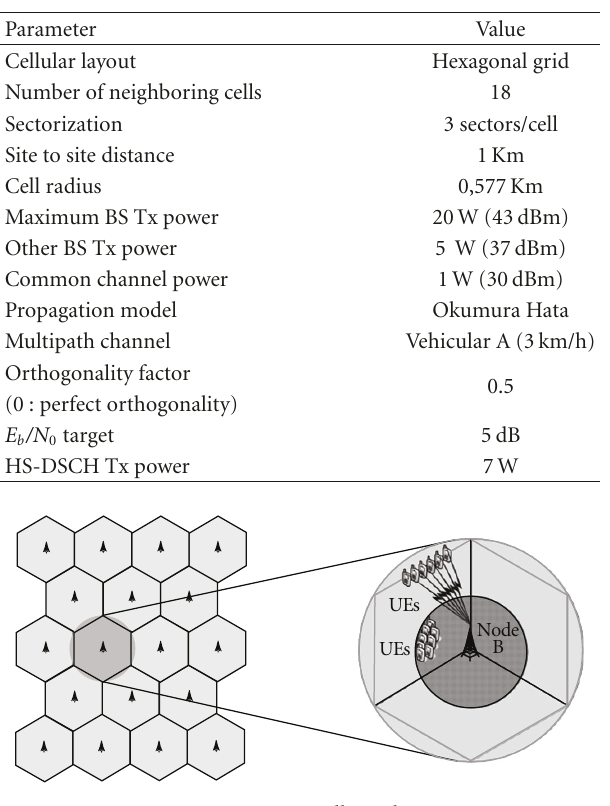
Figure 2: Macrocell topology.